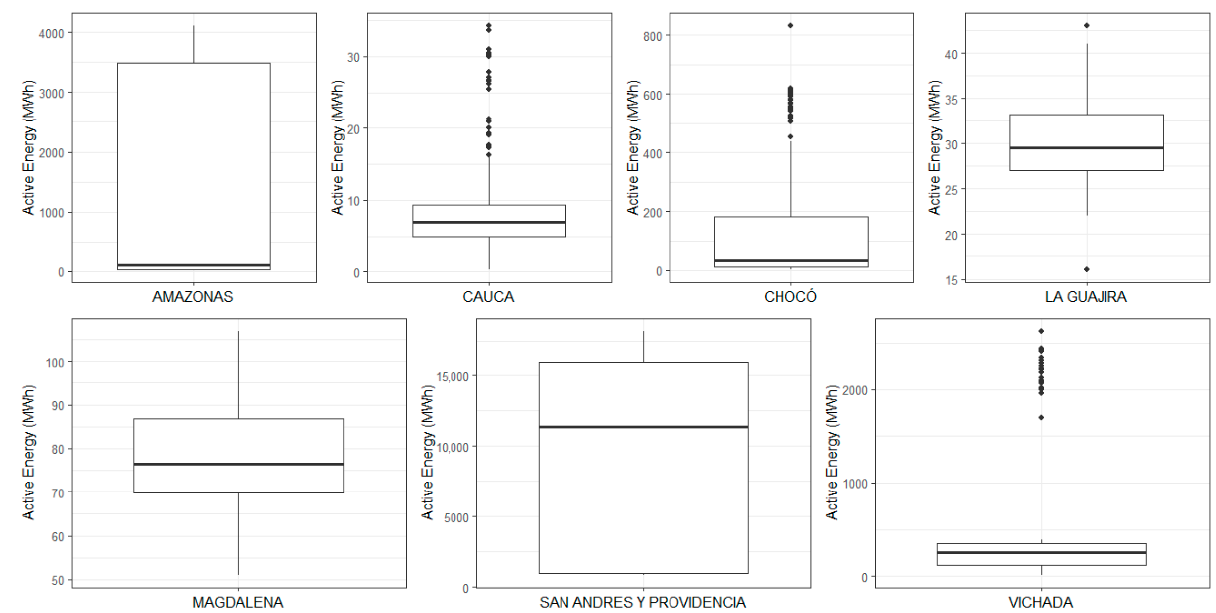
Figure 1. Box and whisker: active energy for shire county.